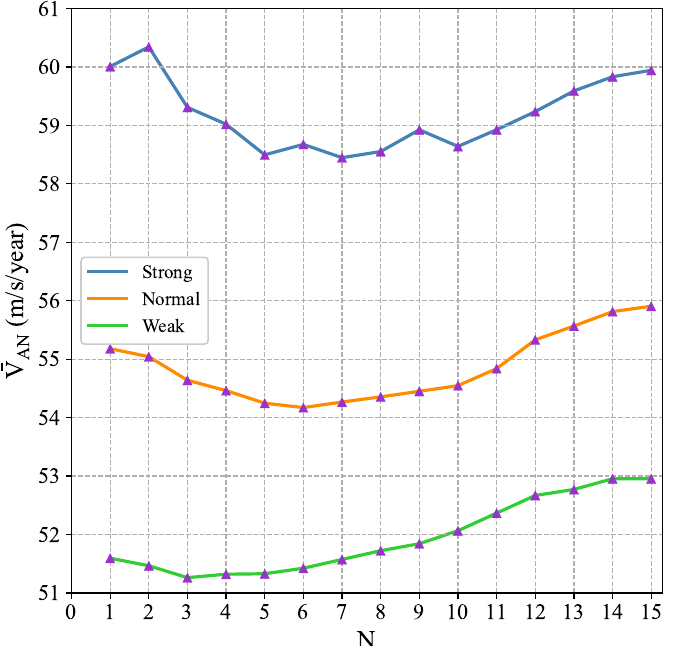
Figure 13. The results of Monte Carlo simulations for the prediction horizon N under different levels of constraints.